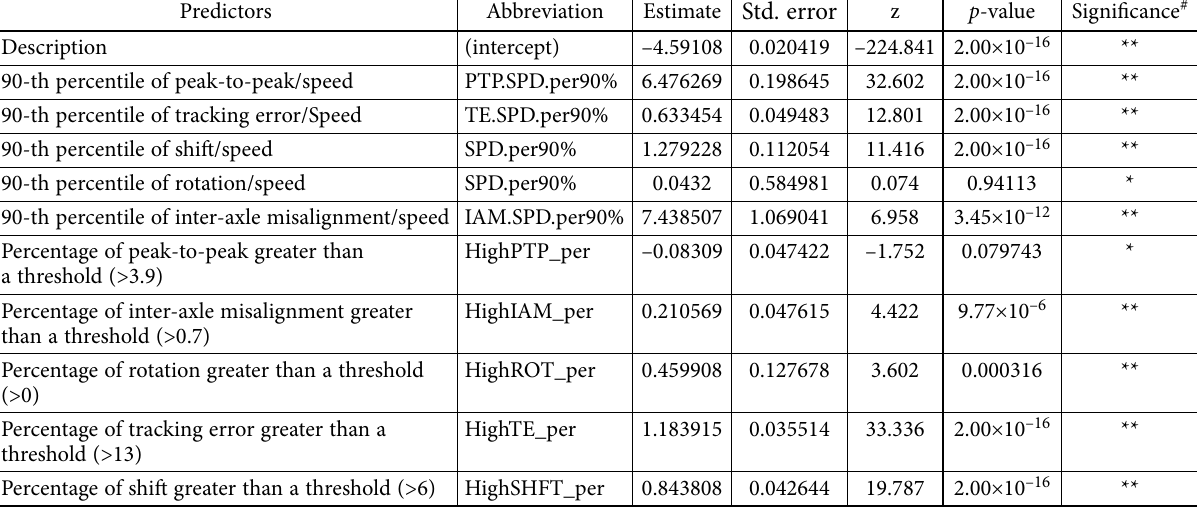
Table 3. The results of logistic regression between truck measurements (explanatory